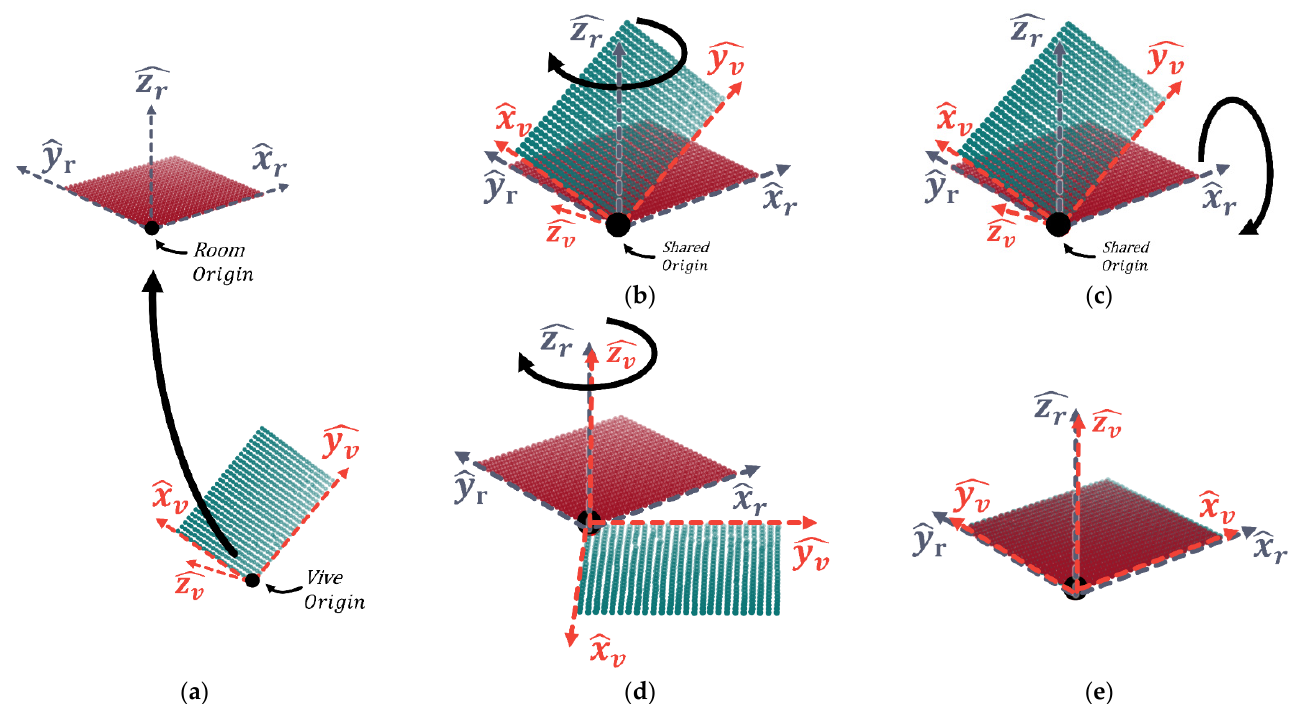
Figure 4. Using Z-X-Z Euler angles to derive an initial alignment between the vive co-ordinate reference frame ( ˆ x v , ˆ y v , ˆ z v ) and the room co-ordinate frame ( ˆ x r , ˆ y r , ˆ z r ) . A translation aligns the origins ( a ); then, ˆ z v is aligned with the ˆ z r , ˆ y r plane via rotation around ˆ z r ( b ). This allows a rotation around ˆ x r to align ˆ z r with ˆ z v ( c ). Finally, another rotation around ˆ z r ( d ) completes the alignment ( e ).